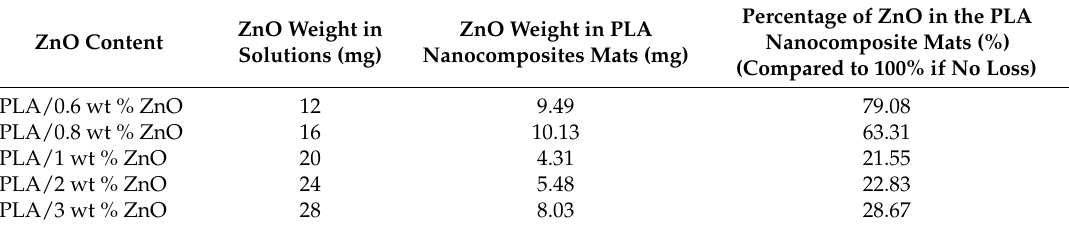
Table 3. Estimation of ZnO-NPs amount in PLA mats produced by the electrospinning process, by